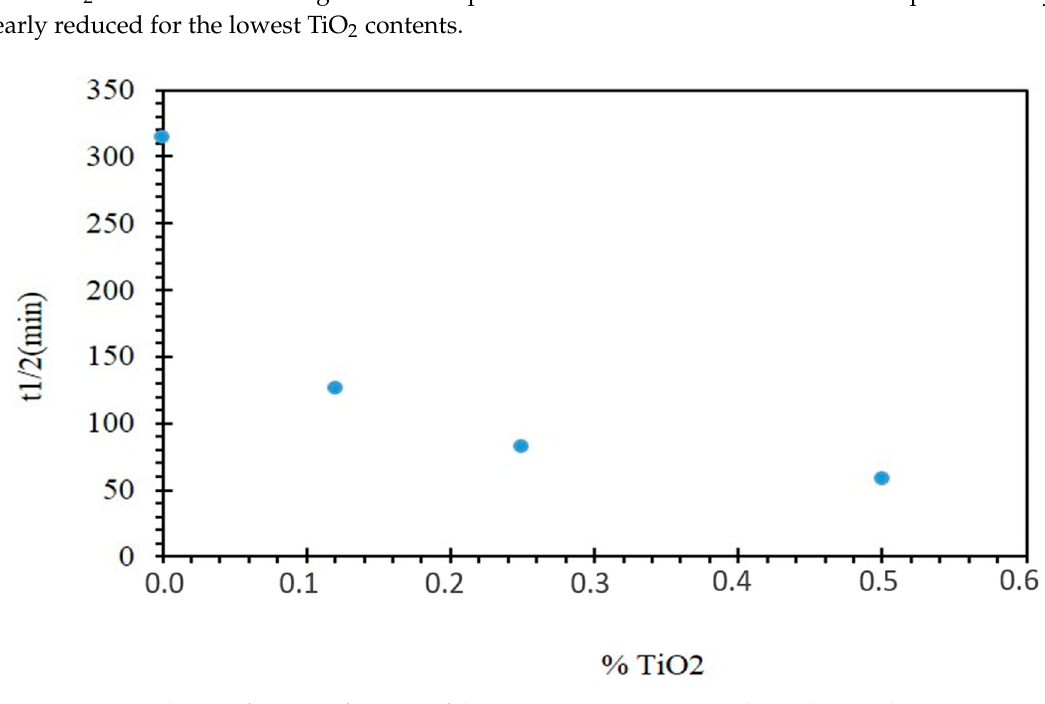
Figure 9. Evolution of t 1/2 as a function of the TiO 2 content incorporated into the membrane matrix.